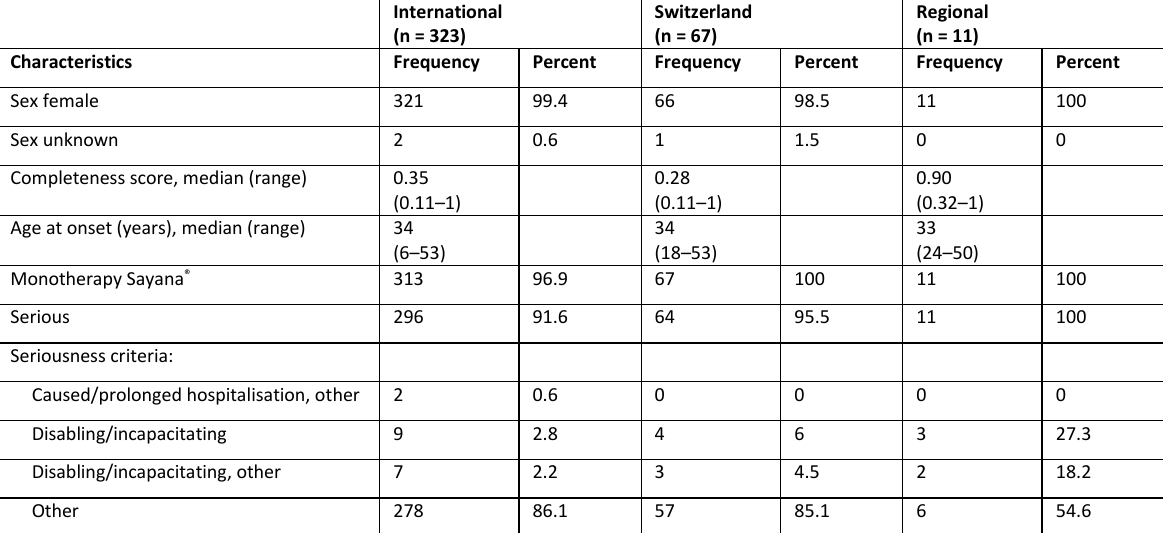
Table 2: Characteristics of the individual case safety